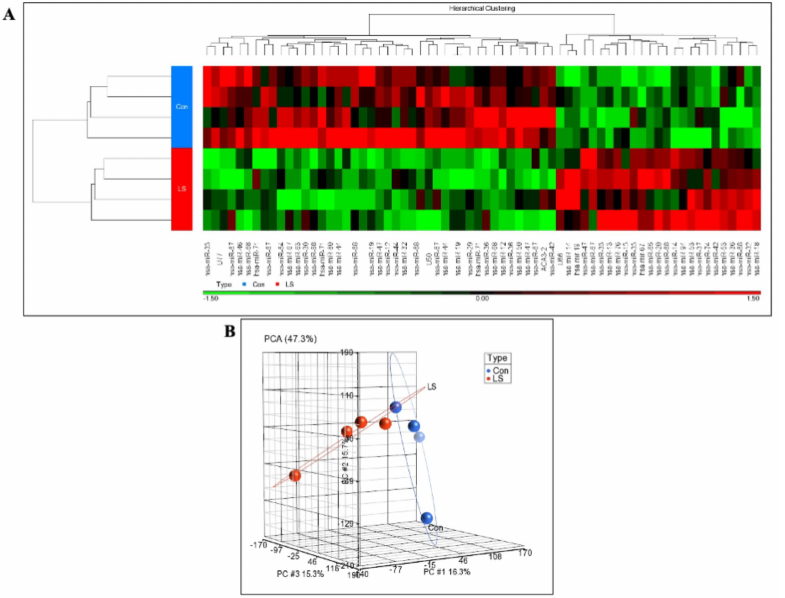
Figure 1. Genome-wide microRNA profiling of LS patients. ( A ) Hierarchical cluster analysis (Pear- son’s Dissimilarity, Ward’s method) performed for 68 differentially-expressed miRs ( p < 0.05 and fold-change difference = 1.5), with four LS and four control samples. ( B ) Principal component analysis (PCA) display of four LS (red dots) and four control (blue dots) samples used in the experiment. PCA demonstrated a good discrimination between